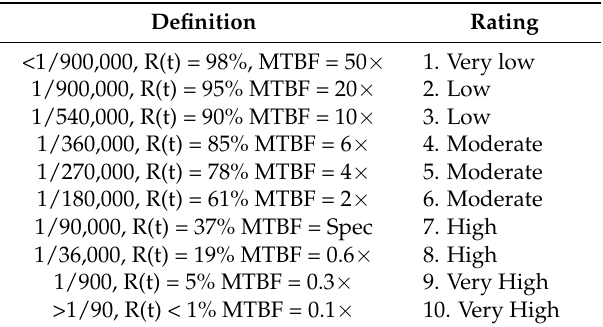
Table 2. Occurrence ratings of failures/cycles (O).